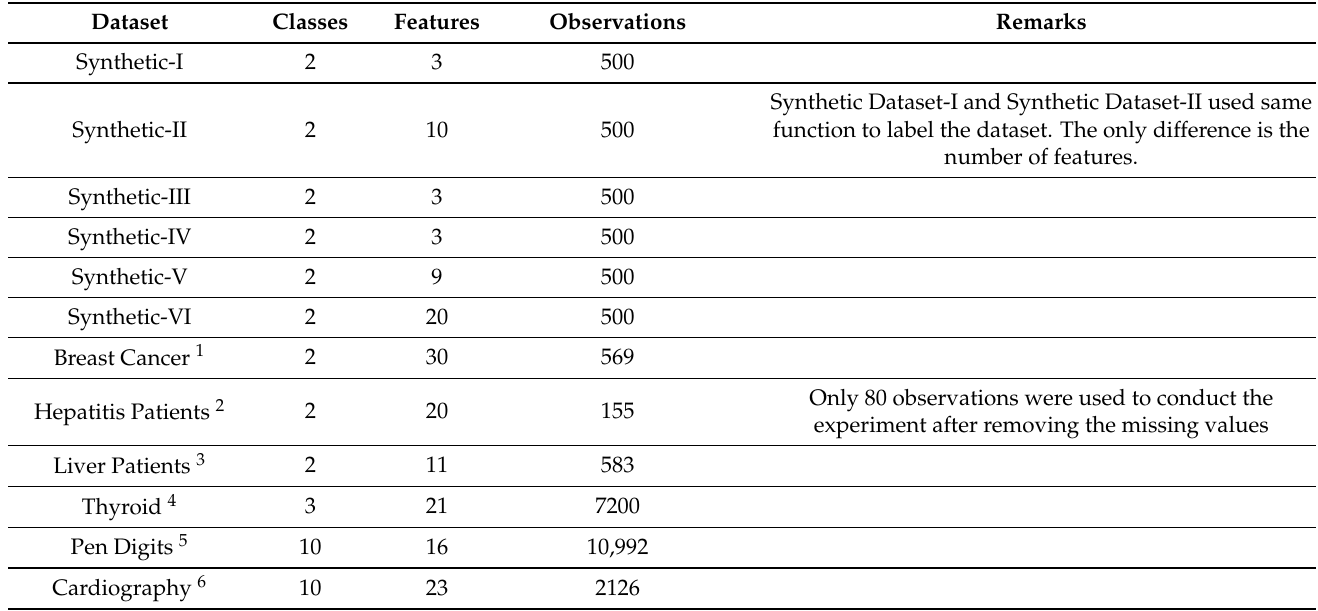
Table 1. Description of the datasets. Numerical attributes were discretized into quartiles after computing mean and standard deviation. For categorical attributes, frequency of each value is computed.